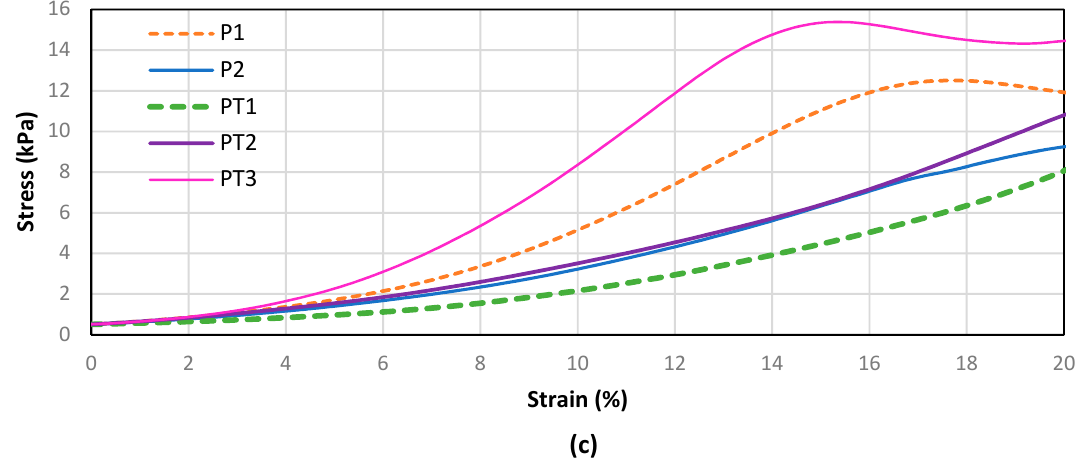
Figure 3. Compression stress-strain curves of ( a ) spacer fabric samples without inlay, ( b ) spacer fabric samples inlaid with silicone-based materials and ( c ) all of the fabric samples with a load strain up to 20%.